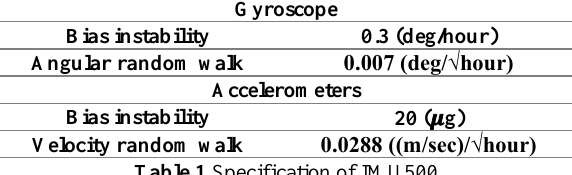
Table 1 .Specification of IMU500